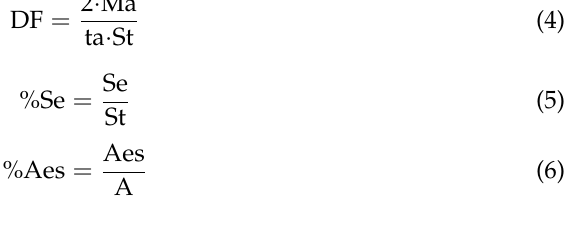
Table 1. Variables and values assigned in the